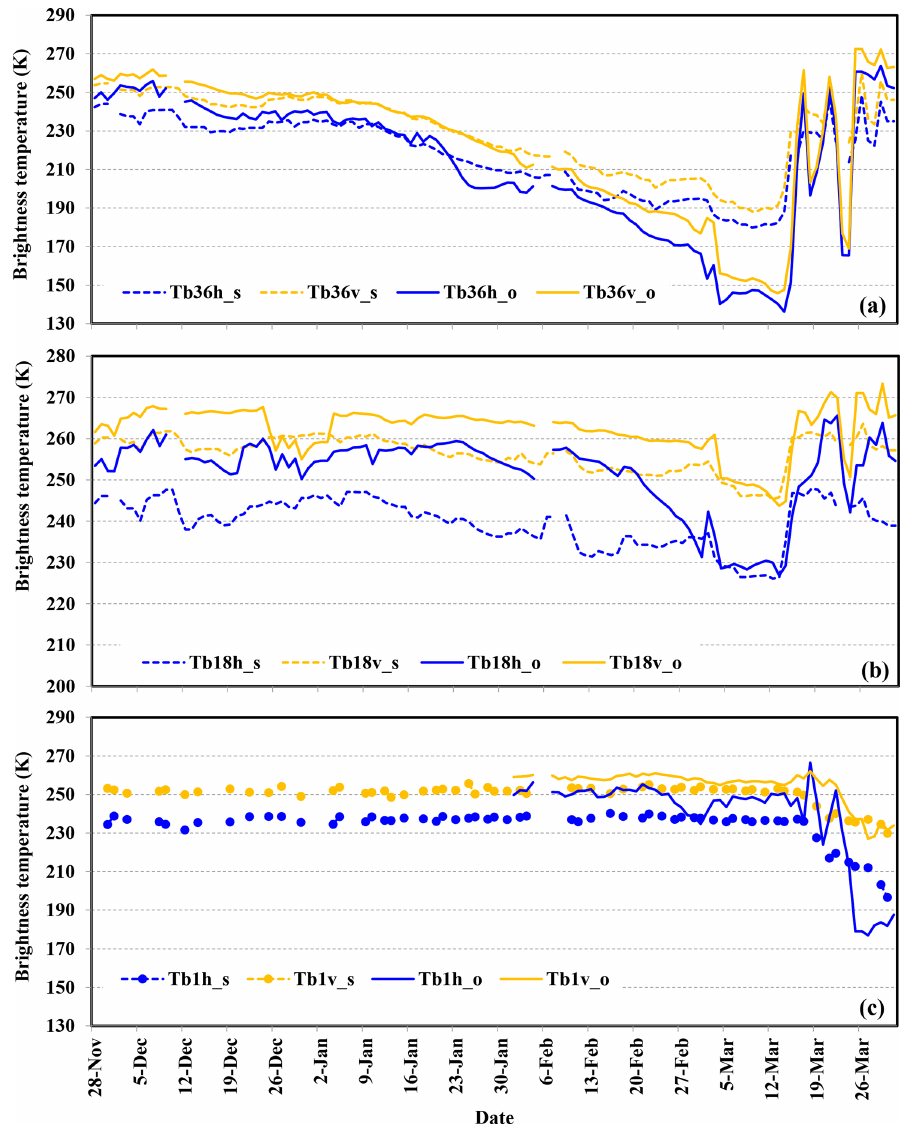
Figure 14. Comparison of brightness temperature between ground-based (o) and satellite-based (s) observations (a) for 36GHz, (b) for 18GHz, and (c) for